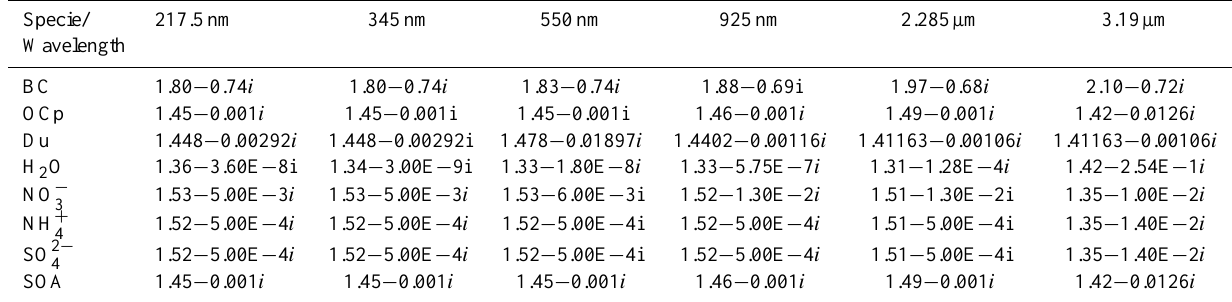
Table 1. Refractive indices used for the main aerosol species at six wavelengths from Krekov (1993) and from Tulet et al. (2008) for dust.